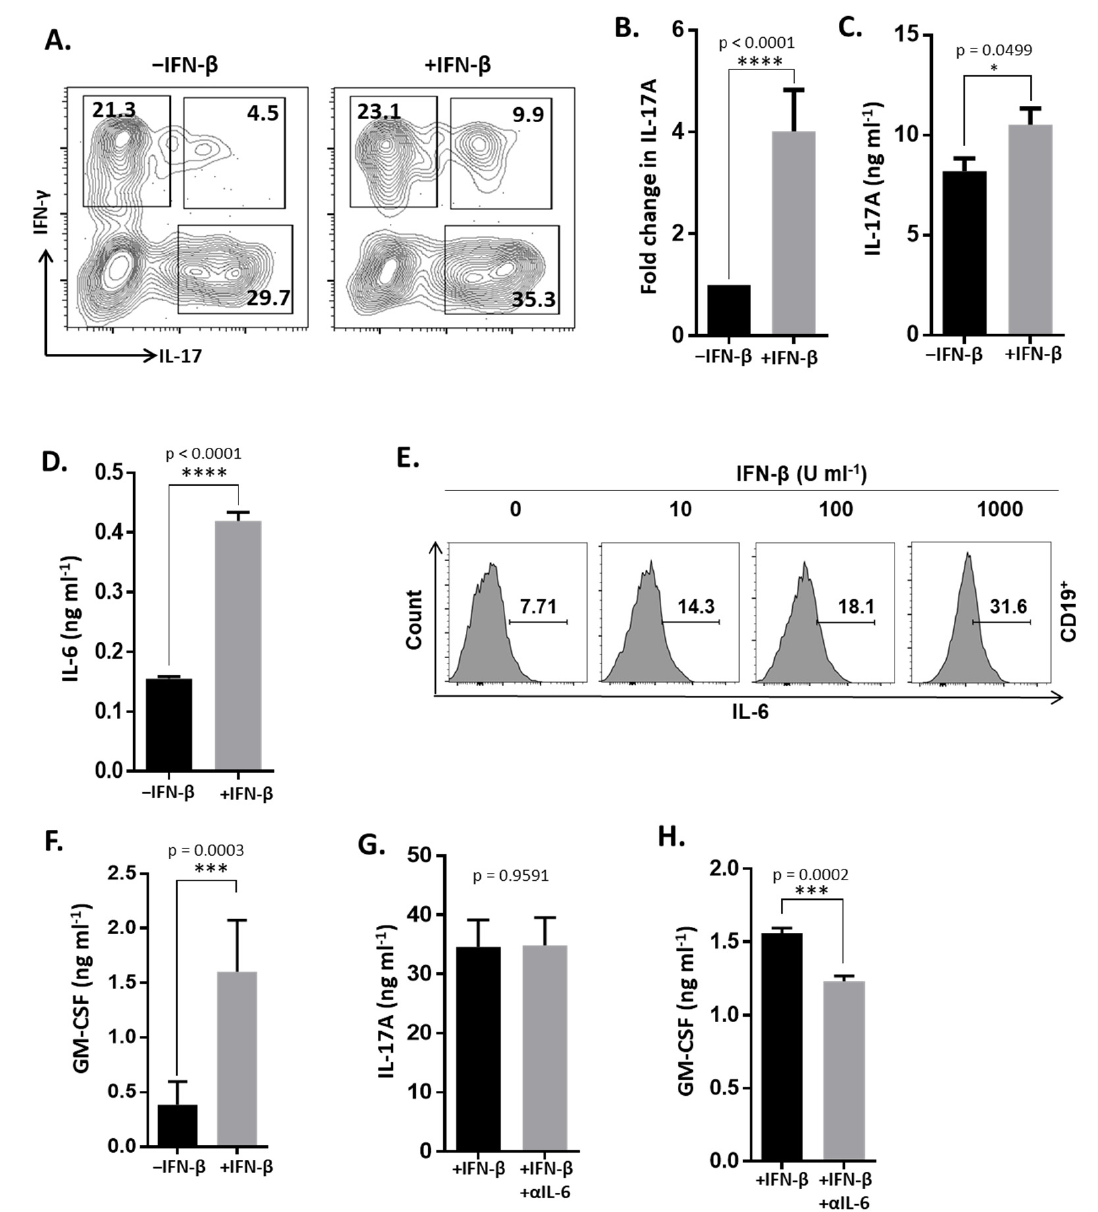
Figure 2. IFN- β induces inflammatory cytokine expression in IL-23-stimulated TH17 cultures. Spleen and lymph node cells of MOG-immunized C57BL/6J mice were cultured with MOG 35–55 , IL-23, and anti-IFN- γ in the presence or absence of IFN- β . ( A ) Representative FACS plots of CD4+ T cells expressing IFN- γ and IL-17. ( B ) Expression of IL-17 transcripts in the cultured cells measured by qRT-PCR. ( C ) Secreted IL-17 levels in the culture supernatants measured by ELISA. ( D ) Secreted levels of IL-6 in the culture supernatants measured by ELISA. ( E ) Intracellular IL-6 was measured in CD19 + B cells by flow cytometry. ( F ) GM-CSF in the culture supernatants measured by ELISA. The concentration of ( G ) IL-17 and ( H ) GM-CSF from culture supernatants from IFN- β ± α IL-6 stimulation were assessed by ELISA. Statistical analysis was determined using Mann − Whitney tests. p values < 0.05 were considered significant (**** indicates p < 0.0001, *** indicates p < 0.001, * indicates p < 0.05). Error bars indicate s.e.m.